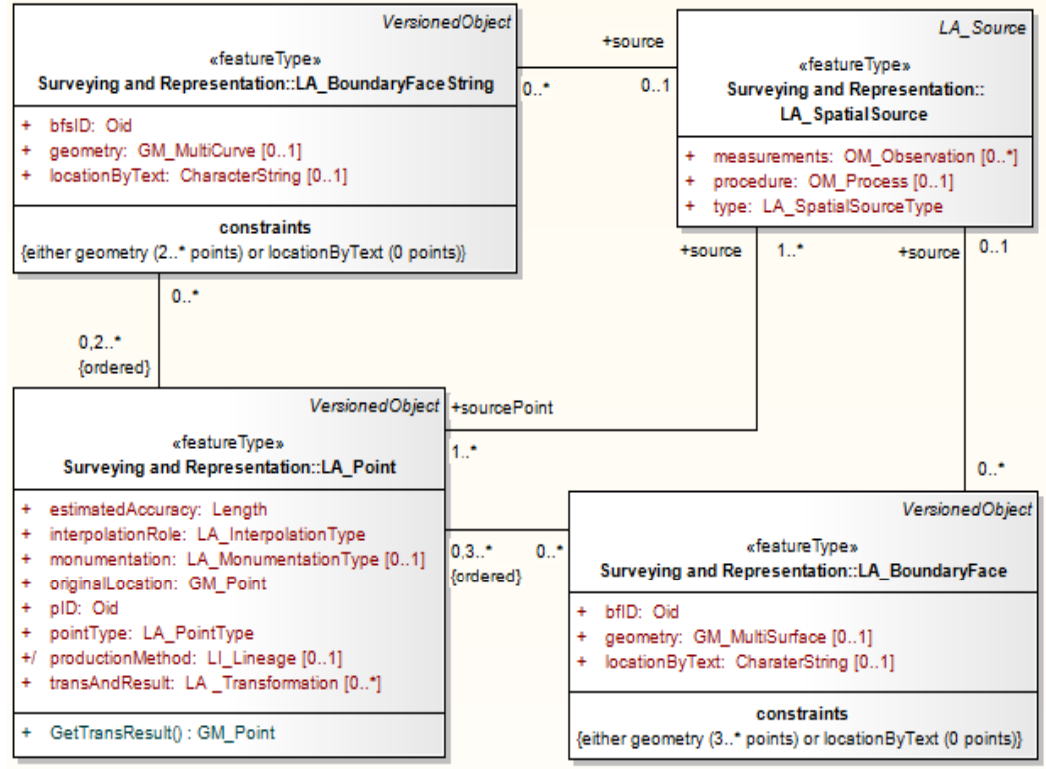
Figure 6. Surveying and Representation package classes (ISO, 2012)